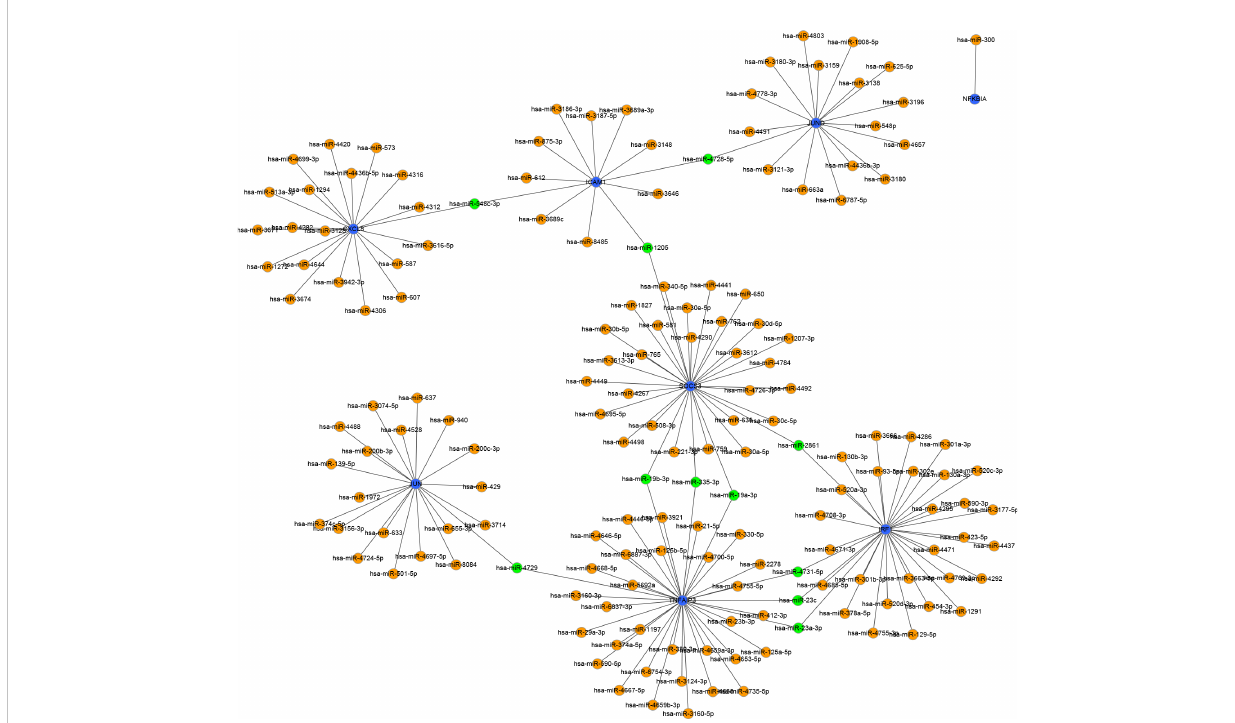
FIGURE 7 Interaction network between immune-related hub genes and their targeted miRNAs. The immune-related hub genes are represented as blue, the miRNAs are represented as orange, and the cross-linked miRNAs are represented as green.